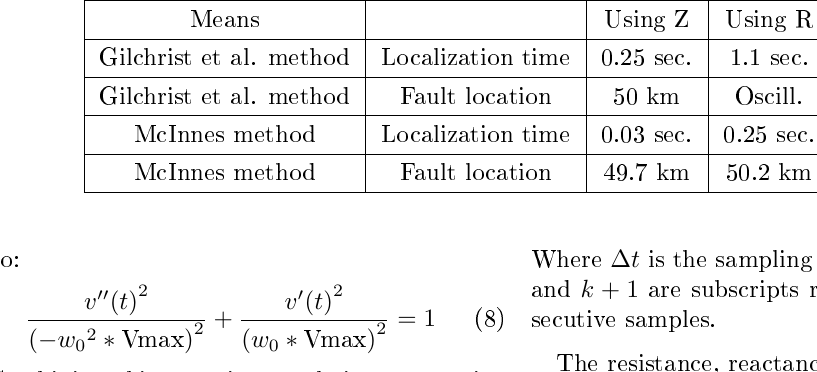
Table 1. Comparison of the two methods Means Using